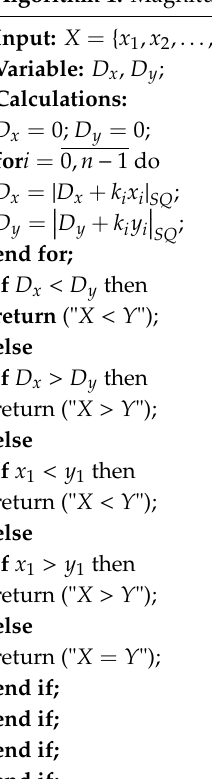
Algorithm 1. Magnitude comparison using DF